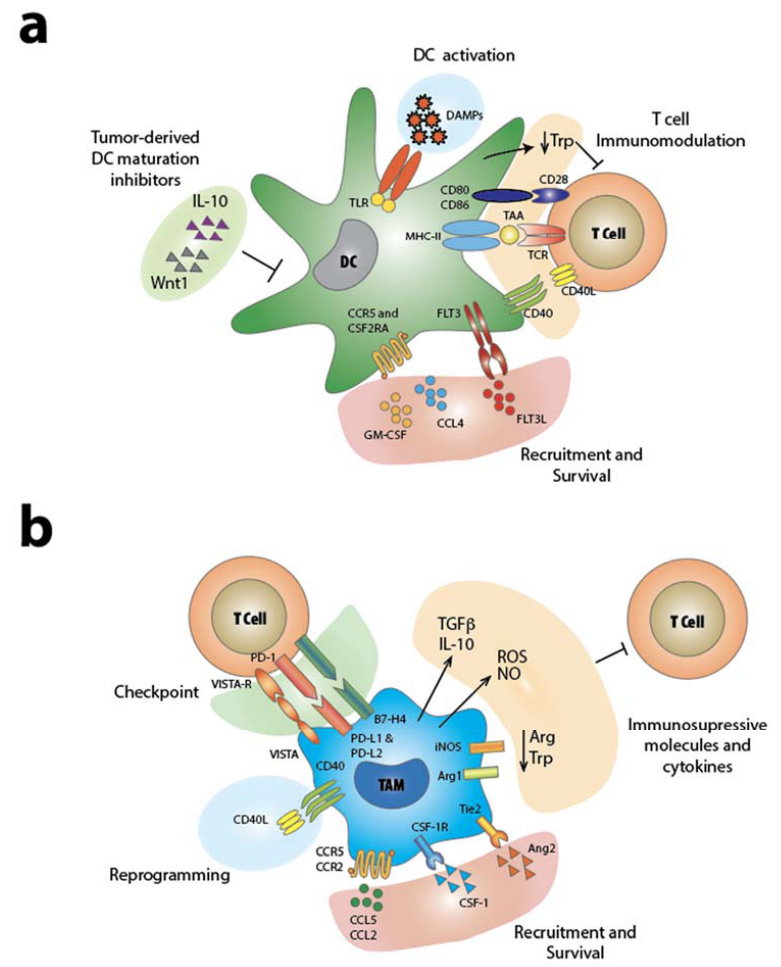
Figure 1. Cross-talk between tumor microenvironment–innate immunity–T cell. ( a ) Dendritic cells (DCs). DCs are recruited in the tumor microenvironment through a series of cues released in the tumor stroma. There, cancer cells produce a series of cytokines that push DCs toward a tolerogenic phenotype. On the other hand, when DCs are activated by DAMPs through their toll-like receptors (TLRs), they mature and they sustain T cell activation and function. ( b ) Tumor-associated macrophages (TAMs). TAMs generally display an M2 immunosuppressive phenotype. They are recruited by various cytokines in the tumor microenvironment where they exploit their immunosuppressive function on T cells through di ff erent mechanisms: release of tolerogenic cytokines and checkpoint